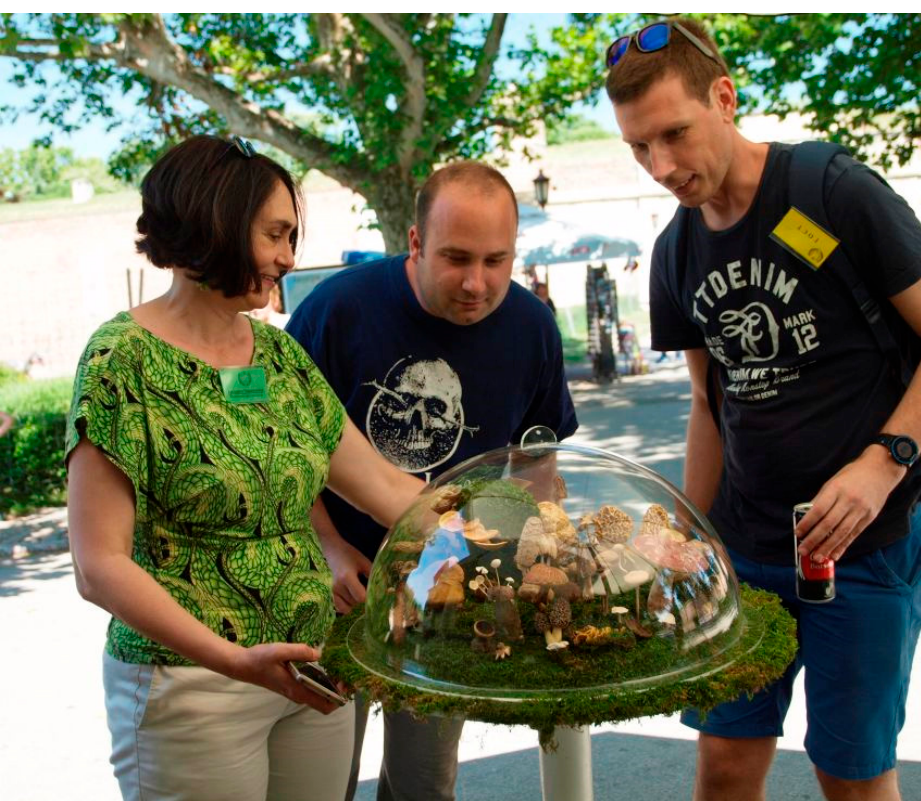
Figure 1. Collection of ethnomycological data in the field.